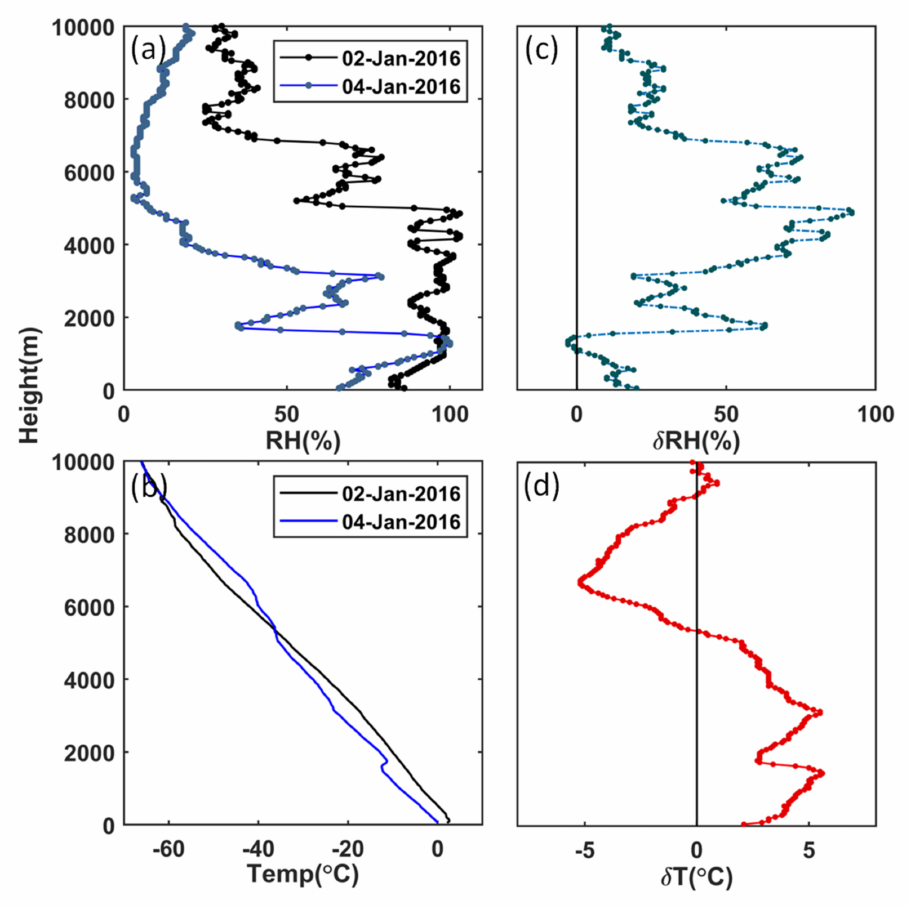
Figure 12. Vertical profiles of temperature and humidity ( a , b ) and their differences ( c , d ) for the heavy rainy day and light rainy